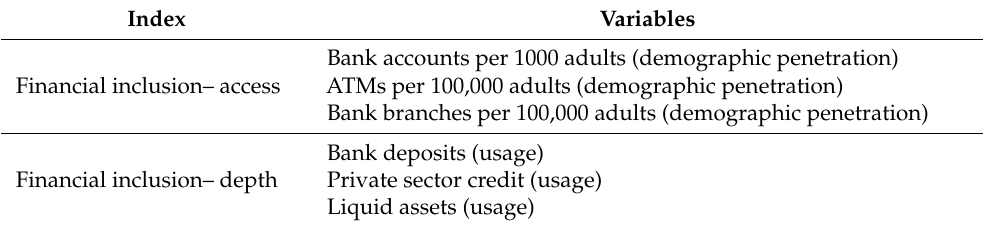
Table 1. Financial Inclusion Main Constructs.